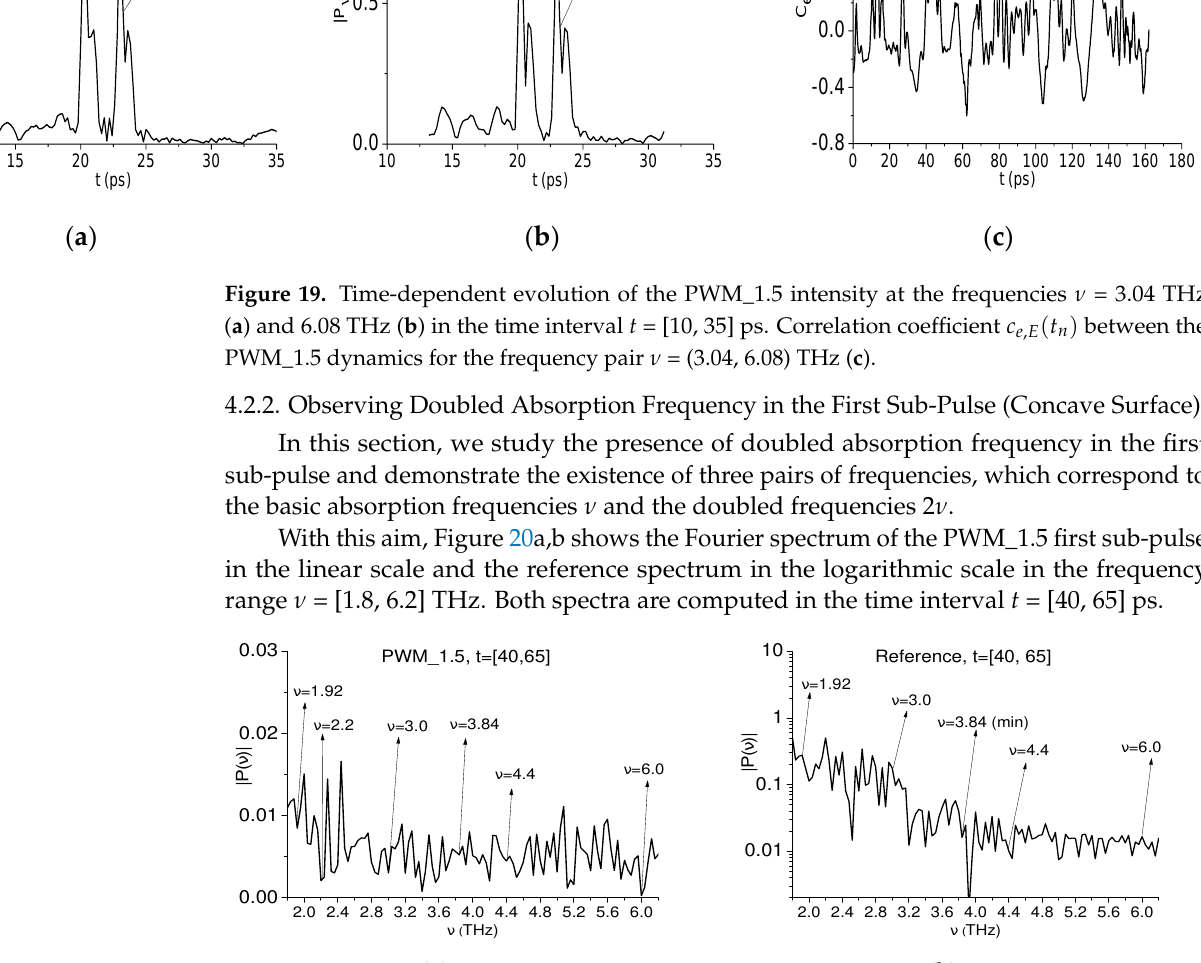
Figure 19. Time-dependent evolution of the PWM_1.5 intensity at the frequencies ν = 3.04 THz ( a ) and 6.08 THz ( b ) in the time interval t = [10, 35] ps. Correlation coefficient , ( ) e E n c t between the PWM_1.5 dynamics for the frequency pair ν = (3.04, 6.08) THz ( c ).